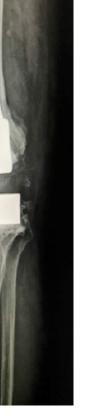
Figure 5: Aseptic loosening in not fully cemented Hinge Revision Total Knee